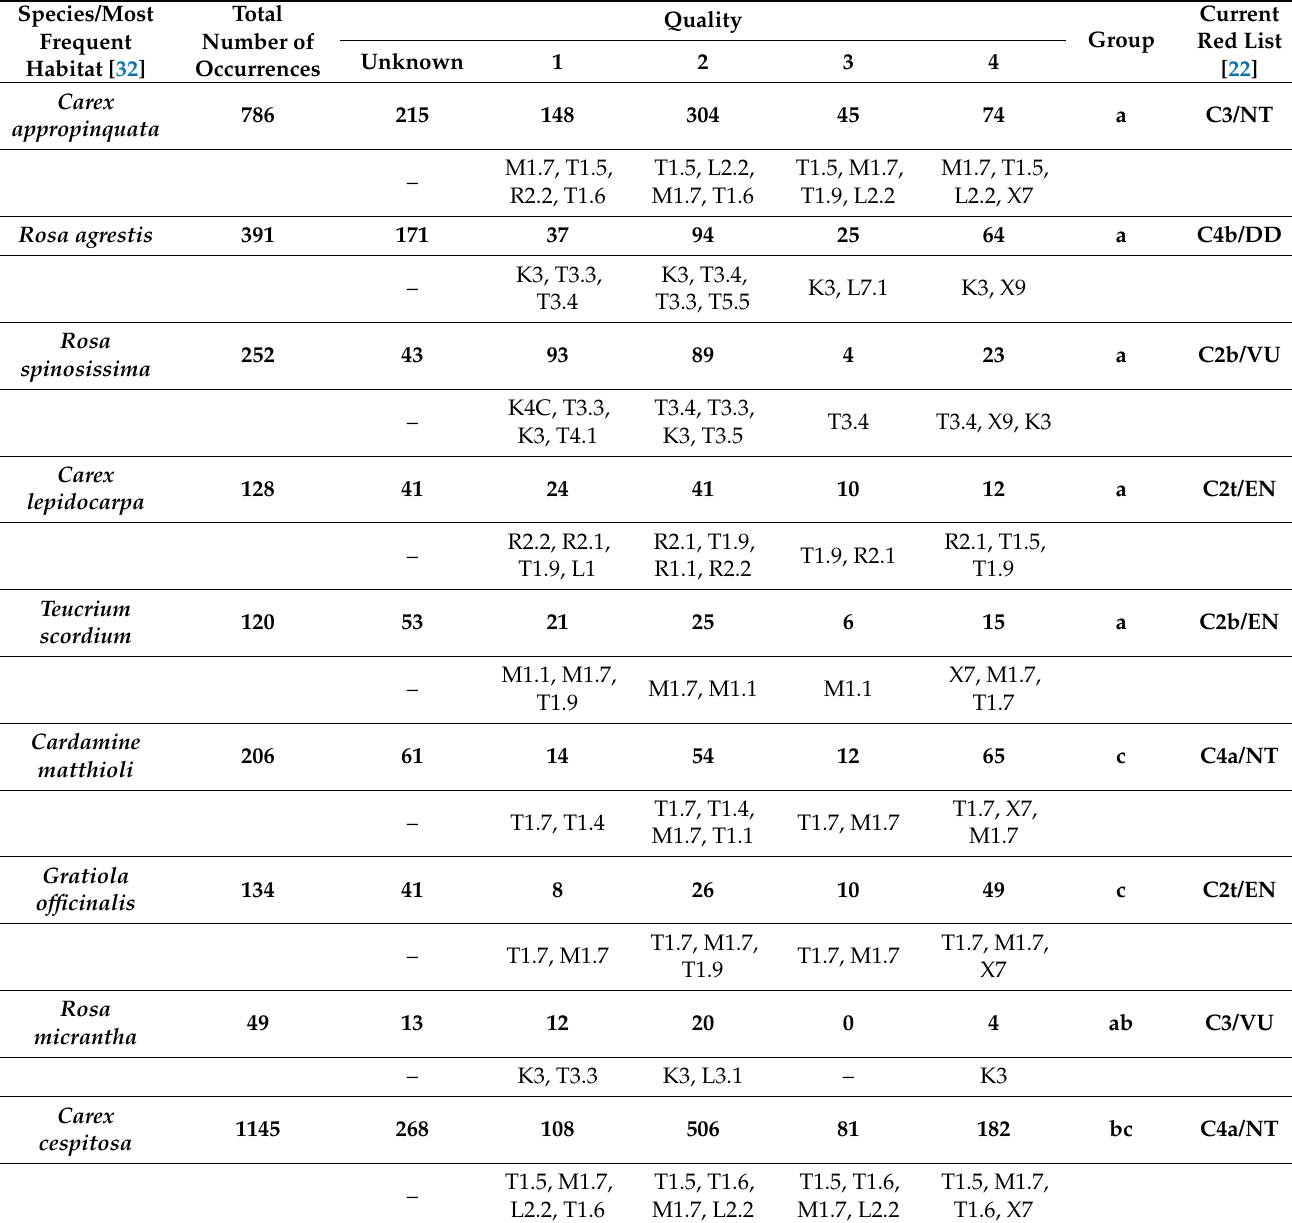
Table 2. Frequency of occurrence of the selected species in habitats of different